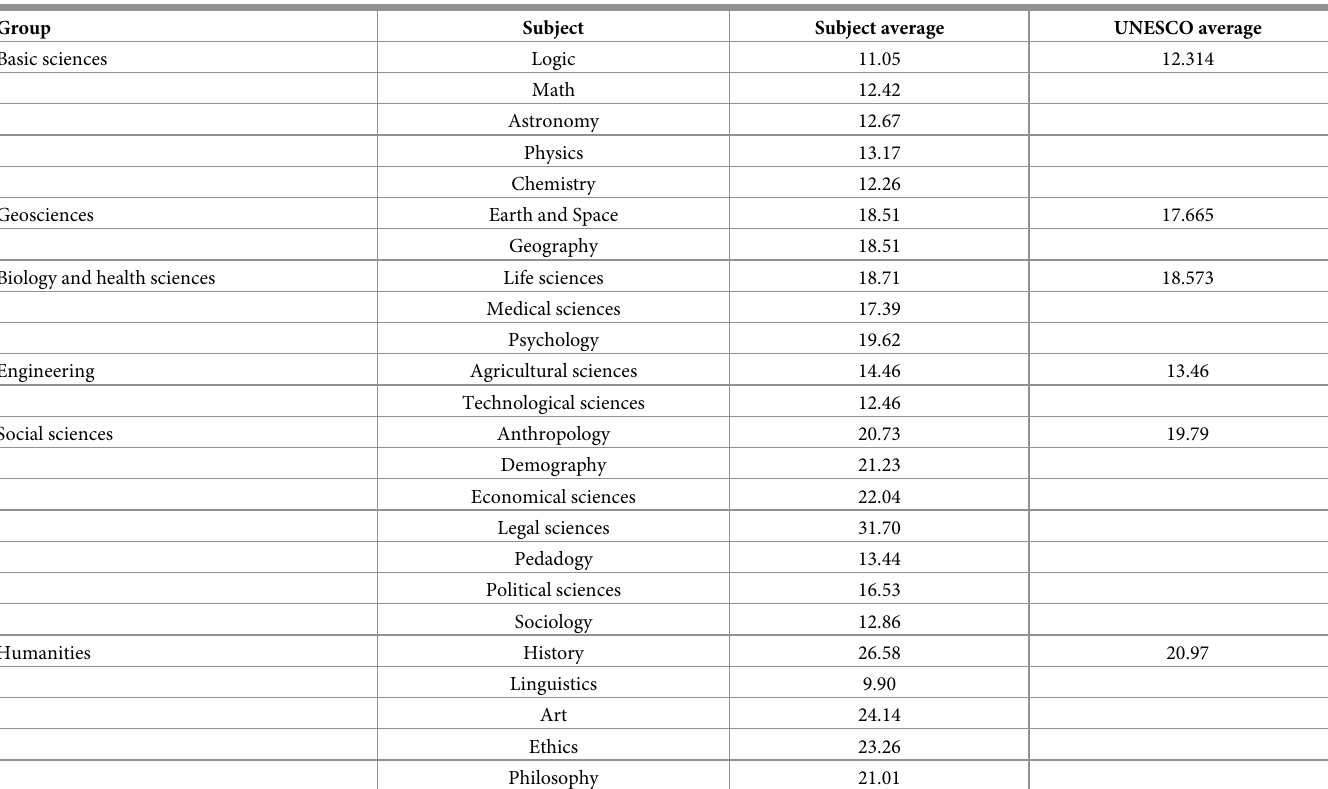
Table 10. Age of the author, and impact on non-inclusiveness.